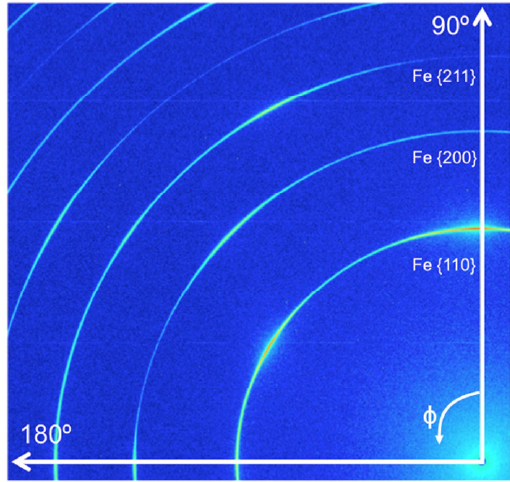
Figure 7. Diffraction pattern of un ‐ irradiated MA957; the tensile direction is at 90°.